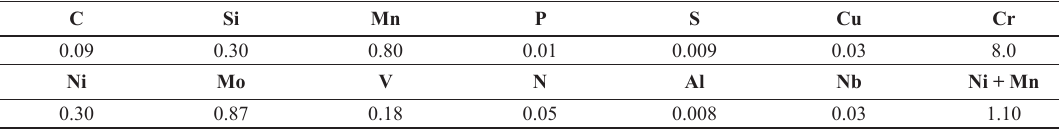
Table 3. Chemical composition of metal cored electrode E90C-B9 (% weight).